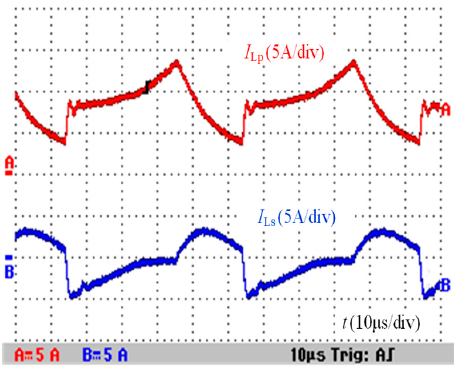
Figure 9. The currents flowing into both sides of the coupled inductor.